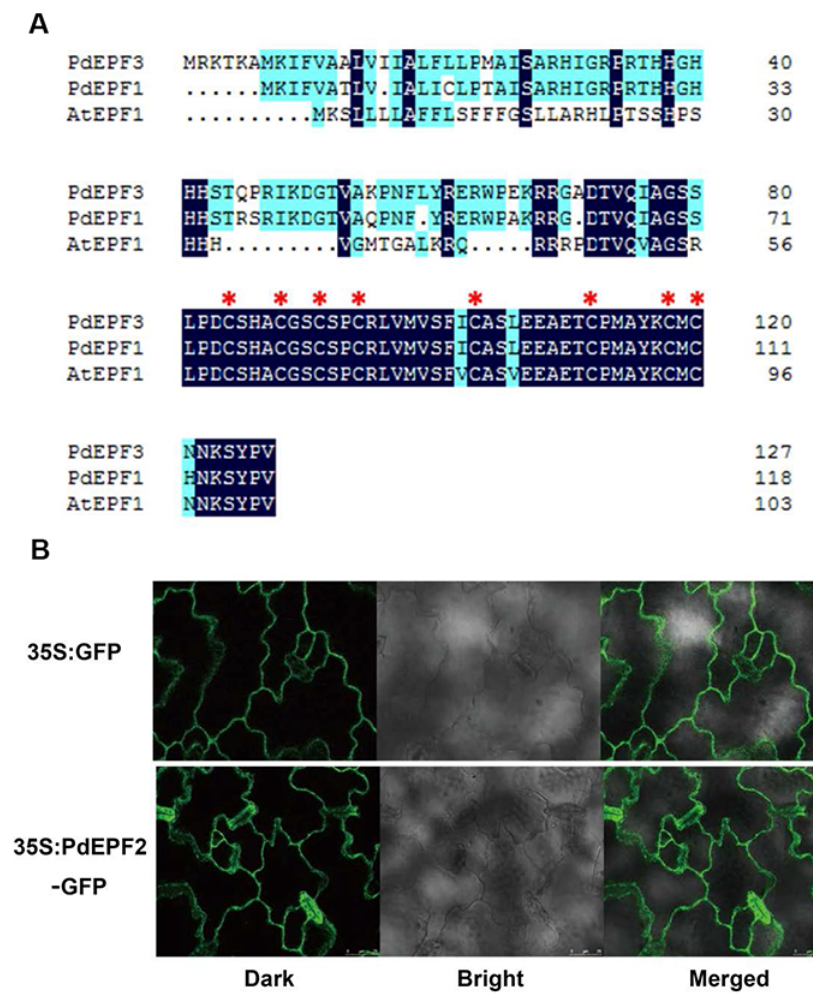
Fig. 1 The identification of poplar PdEPF3 gene. ( A ) Alignment of the putative PdEPF3 mature signaling peptide with the signaling peptides PdEPF1 and AtEPF1. Conserved Cys residues are marked with red asterisks. Amino acid sequences for the mature peptide region were aligned using DNAMAN. ( B ) Subcellular localization of 35S:PdEPF3-GFP and control 35S:GFP expression in epidermal leaf cells. The photographs were taken in dark field, bright field, and merged field.